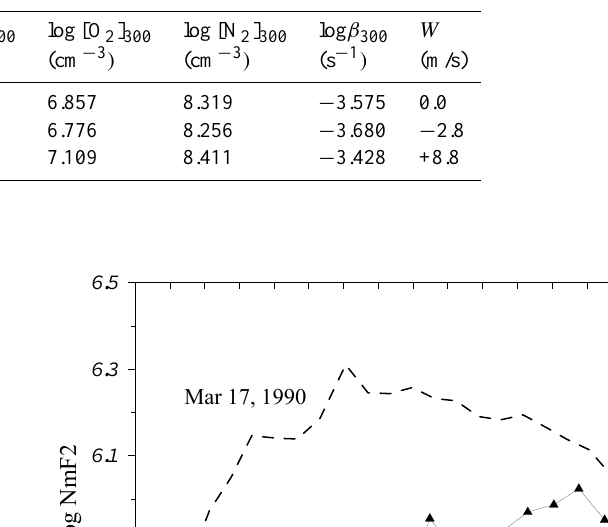
Table 1. Calculated aeronomic parameters at 300km for 15, 16, 18 April 2002. Italic – Millstone Hill Tex estimates.